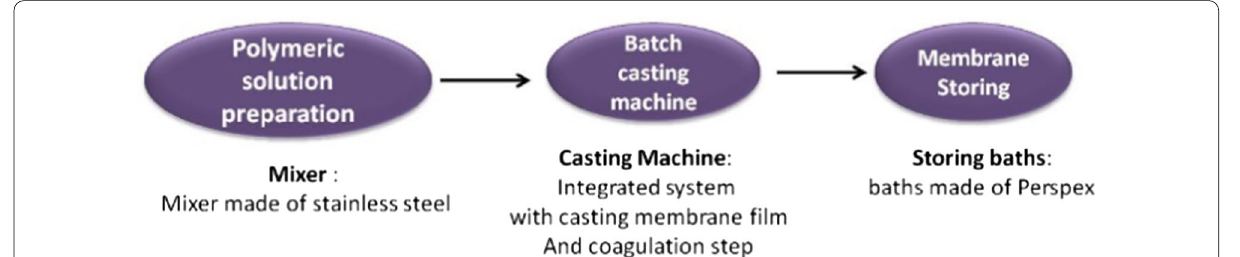
Fig. 5 Membrane production design flow